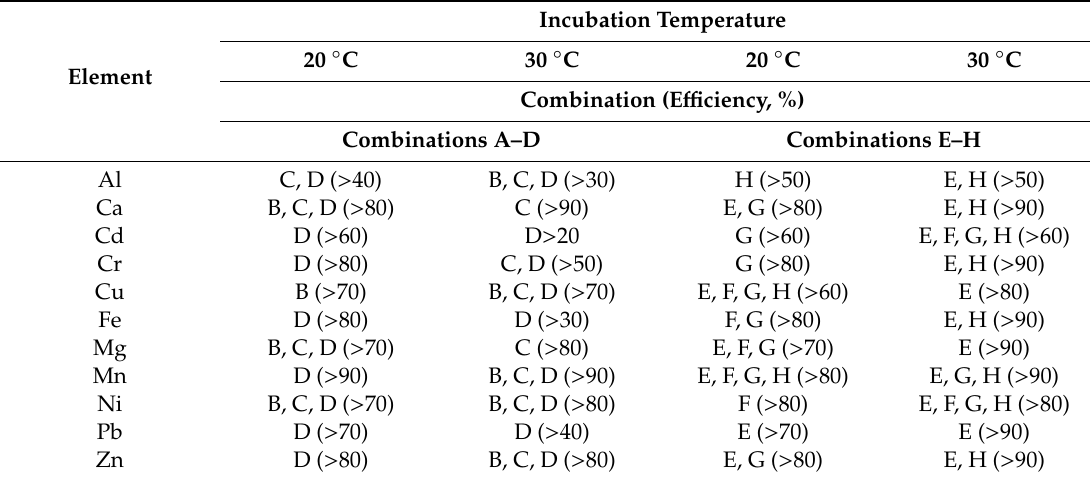
Table 4. Combinations with the highest leaching e ffi